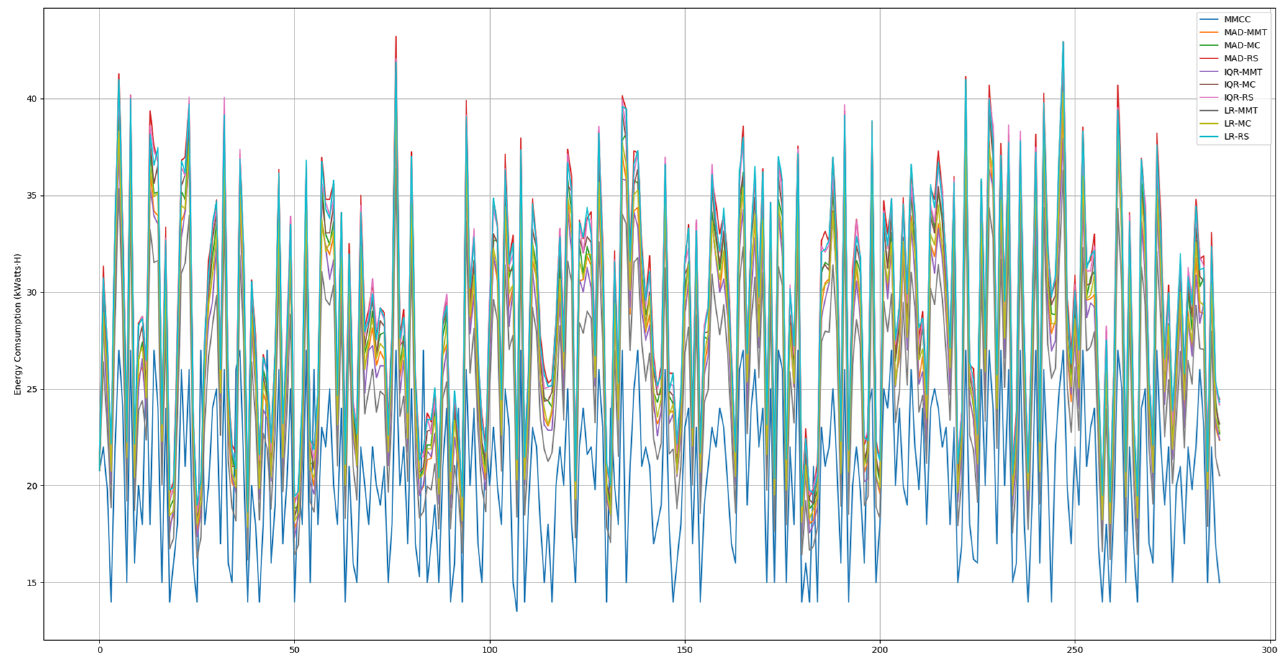
Figure 8. Comparing the energy consumption of hosts by all methods in every time segment.